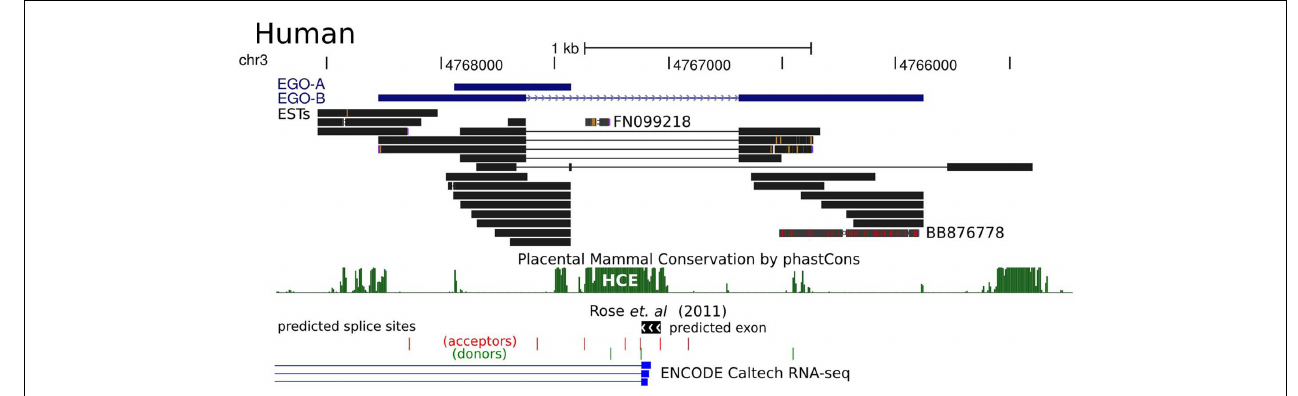
FIGURE 5 | Experimental evidence for transcription. The figure depicts human EST profiles of EGOT. Interestingly, transcription intensity as indicated by the EST profile does not correlate with sequence conservation as measured by phastCons. For example, there is only a single EST (FN099218) at the intronic HCE.Therefore, we speculate that for the depicted locus selective constraints are rather placed on the secondary than on primary structure. However, we have previously predicted a novel exon with